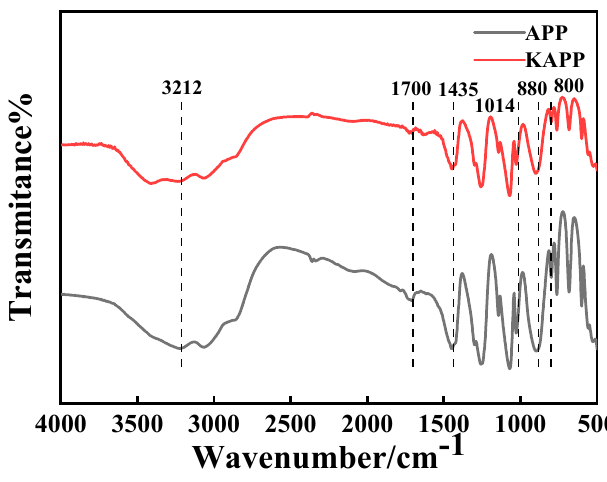
Figure 5. Infrared spectra of APP and KAPP.